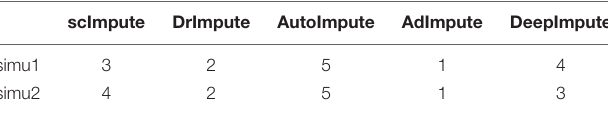
1 represents the best and 5 represents the worst in the